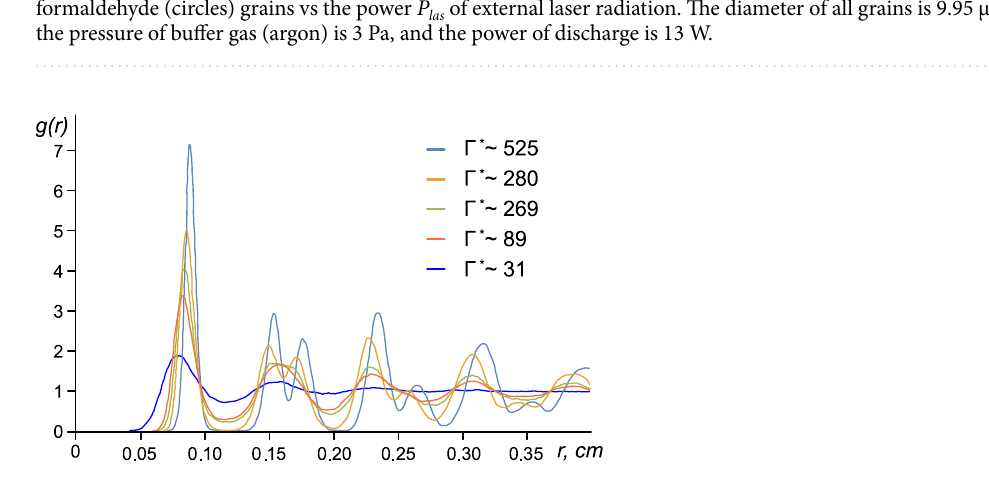
Figure 4. Pair correlation functions g ( r ) for different states of grain monolayers, solid and liquid, at different values of the coupling parameter, Γ * : 1—Γ * = 525 (solid); 2—Γ * = 280 (solid); 3—Γ * = 269 (liquid); 4—Γ * = 89 (liquid); 5 – Γ * = 31